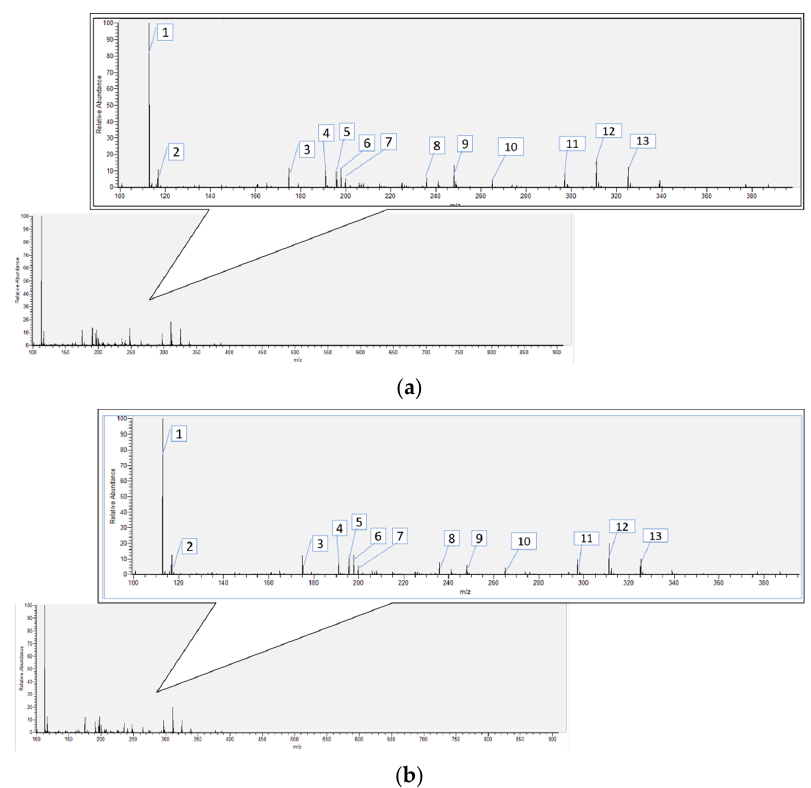
Figure 7. Mass spectrometry at a scan range of m/z 100–900 for [M + H] − of the extracts obtained from optimal ohmic ( a ) and conventional heating ( b ). Table 4. A comparison of the major identified components present in pineapple core extracts from optimal ohmic heating and conventional heating.